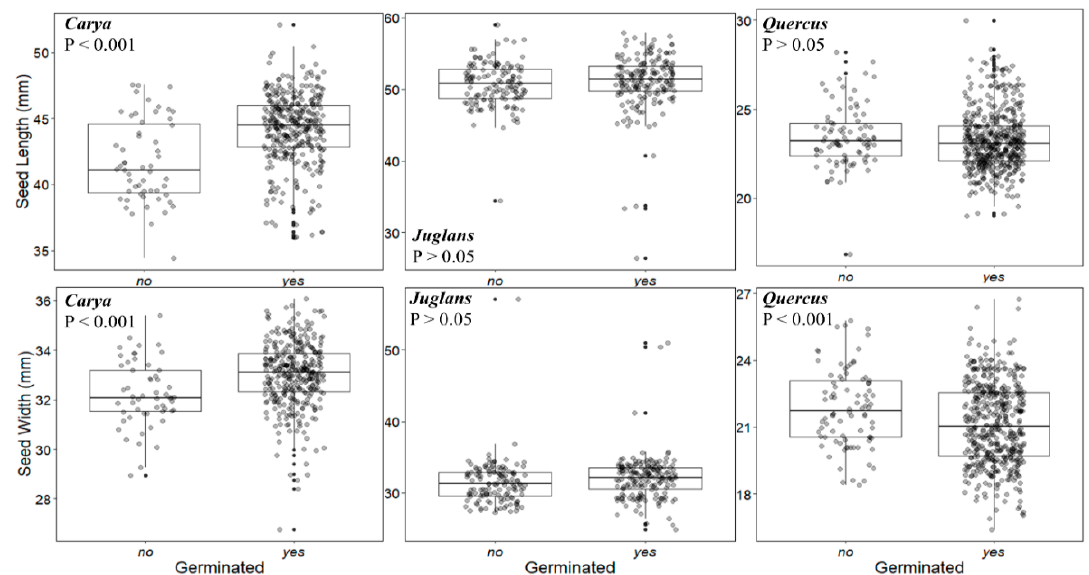
Figure 4. The effect of seed size (length and width of seeds in millimeters) on the germination success of seeds from Carya laciniosa , Juglans cinerea , and Quercus rubra . P-values are from ANOVA comparisons.